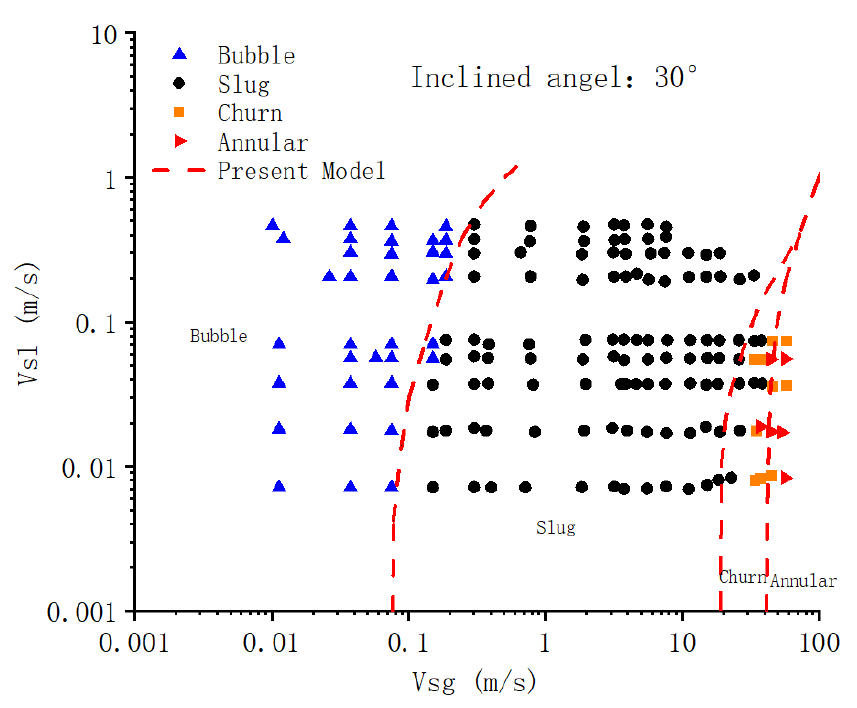
Figure 14. Flow pattern distribution of gas-liquid two-phase flow in the annulus pipe at an inclination angle of 30°.